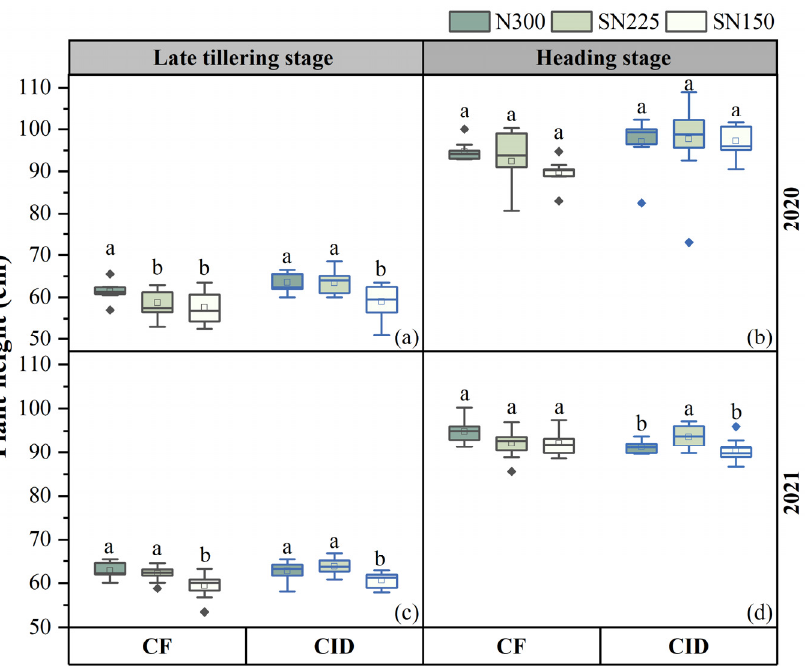
Figure 3. Plant height of Nanjing 9108 rice variety ( Oryza sativa L.) under two water regimes (continuously flooded [CF] and controlled irrigation and drainage [CID]) and three fertilizer practices (conventional farmers’ fertilization of 300 kg N ha − 1 without straw return [N300], straw return with 225 kg N ha − 1 fertilizer [SN225], and straw return with 150 kg N ha − 1 fertilizer [SN150]) at the late tillering and heading stages during the 2020 ( a,b ) and 2021 ( c,d ) rice-growing seasons. The lines, squares, and diamonds in boxplots represent the medians, means and outliers, respectively. Different letters indicate significant differences at p < 0.05. Table 1. Analysis of variance of water regime and N-fertilizer management and their interactions with morphological, photosynthetic and fluorescence